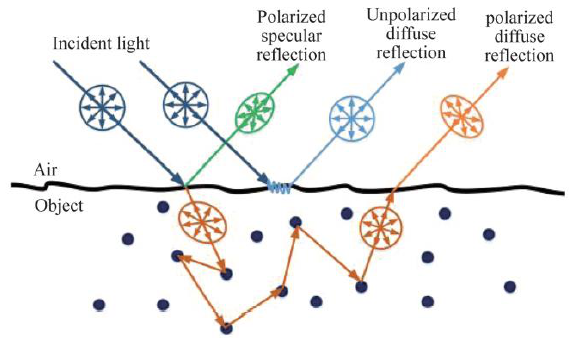
Figure 3. Schematic diagram of the emitted light from different material surfaces.